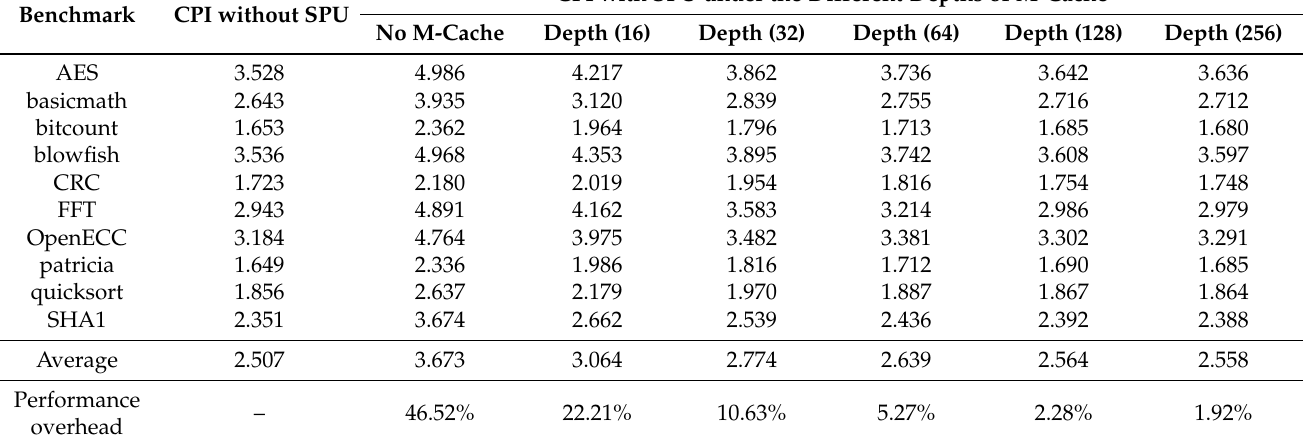
Table 3. Performance overhead of the SPU configured with different depths of M-Cache (8 KB I-Cache and 8 KB